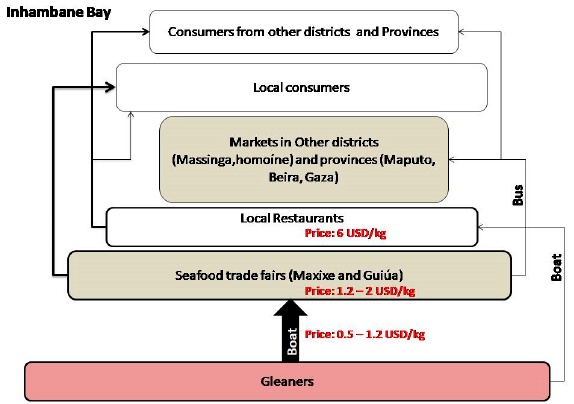
Figure 4. Illustration of the value chain: stakeholders, product flow, and market price variation between stakeholders for Inhambane Island resources. Line thickness indicates the volume of resources transacted (thicker lines indicate higher volumes; thinner lines indicate lower volumes). Gleaners use boats to arrive at the marketplaces.